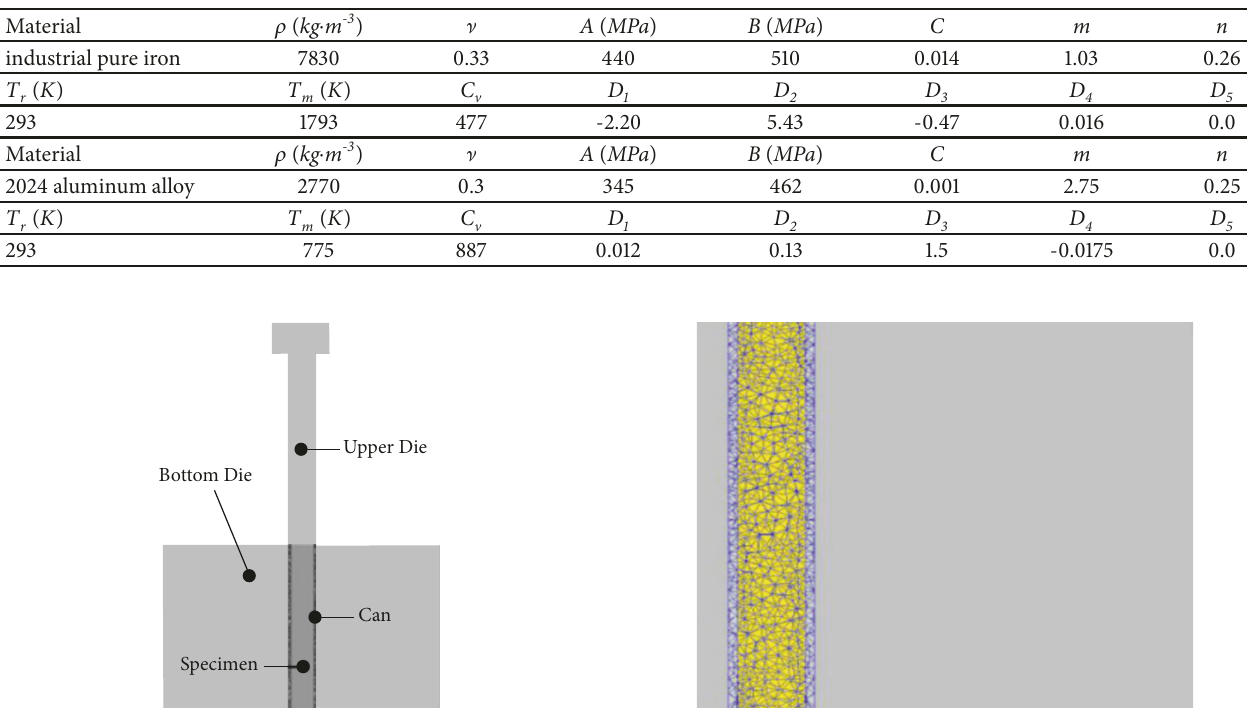
Table 2: Parameters for constitutive equation of canned materials.